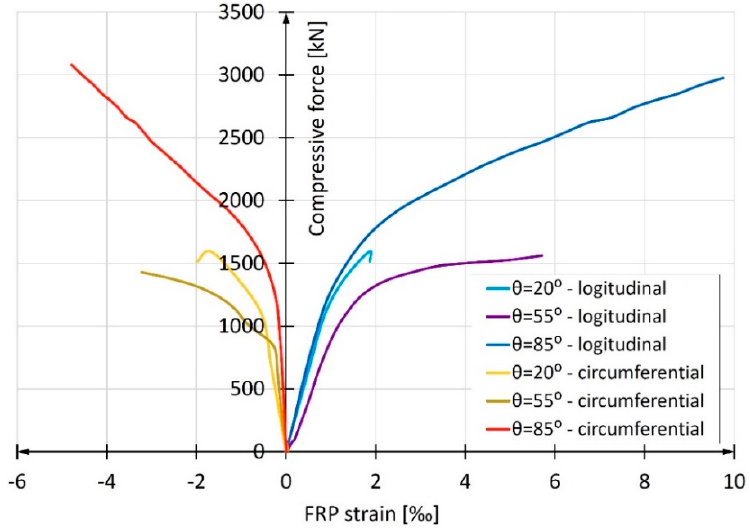
Figure 13. Relation compressive force vs average deformation in short CFFT columns with different fiber winding angles.